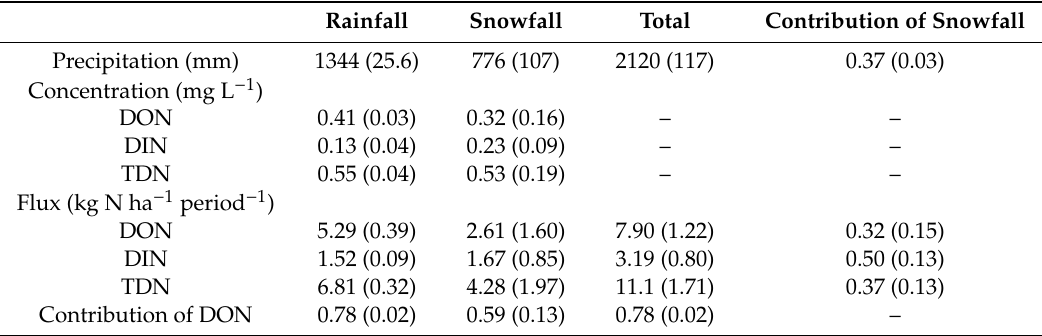
Table 1. Precipitation (mm), average nitrogen concentration (mg L –1 ), and average flux (kg N ha –1 period –1 ) in bulk precipitation during three years (May 2015–April 2018). Values in parentheses are standard deviation ( n = 3). DON = Dissolved organic nitrogen, DIN = Dissolved inorganic nitrogen, TDN = Total dissolved nitrogen.